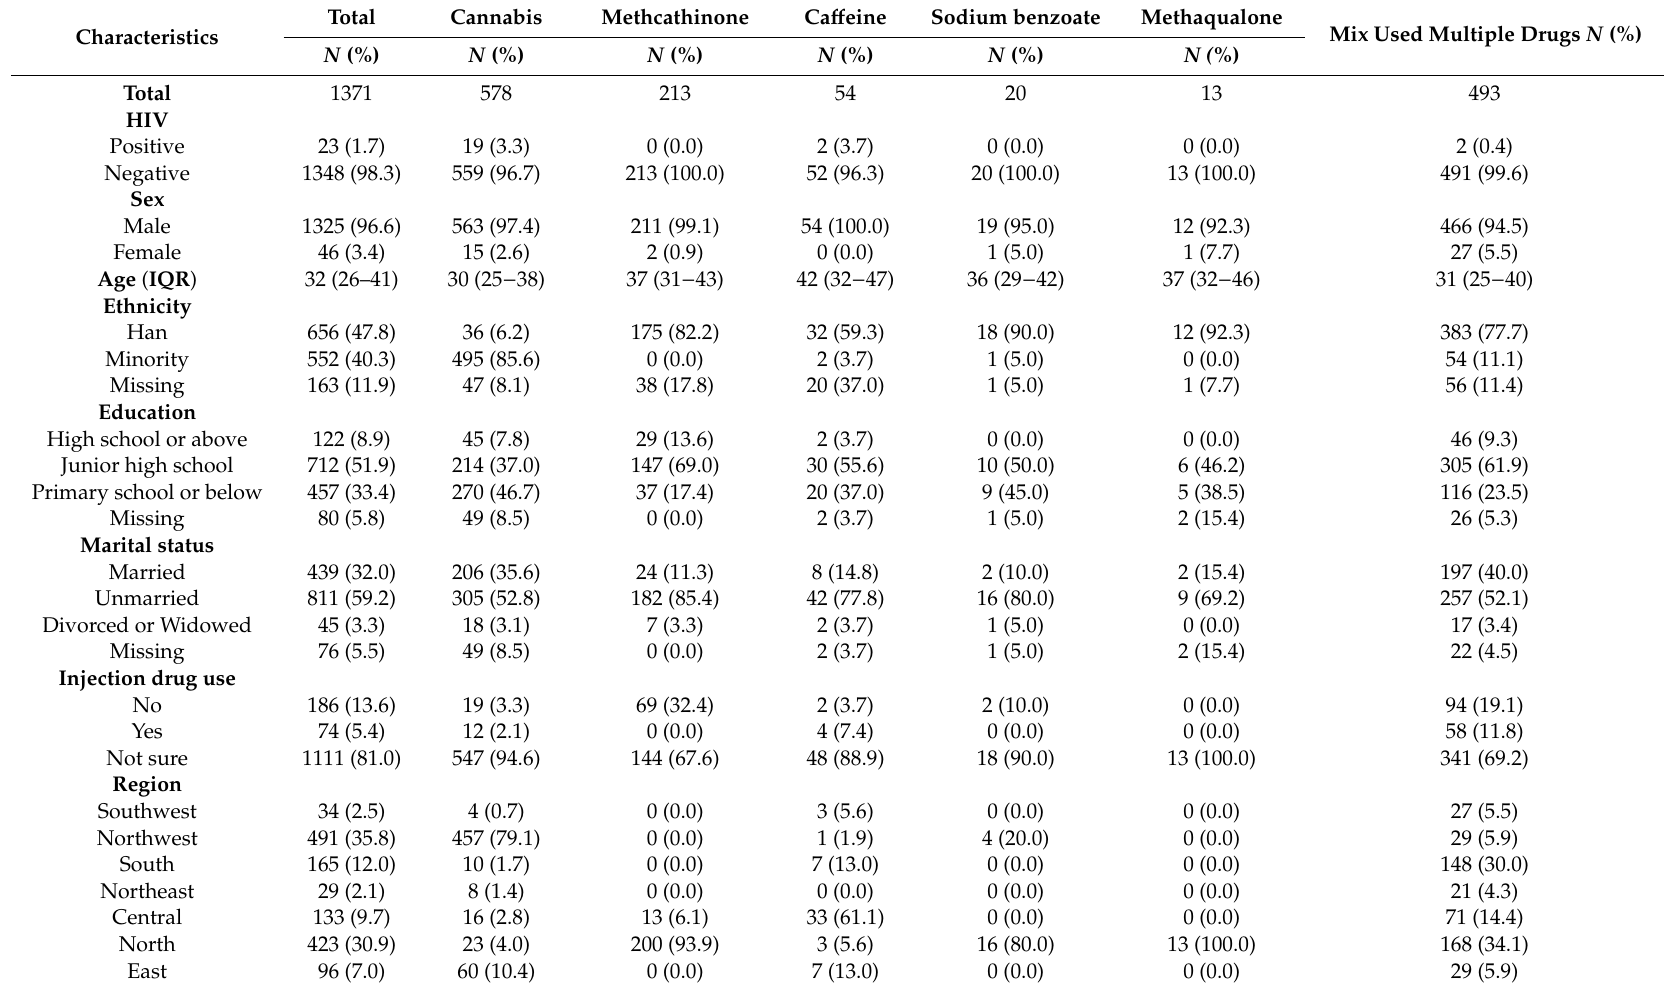
Table A1. Characteristics of drug users who used drugs other than depressants and stimulants in China, 2008–2016.